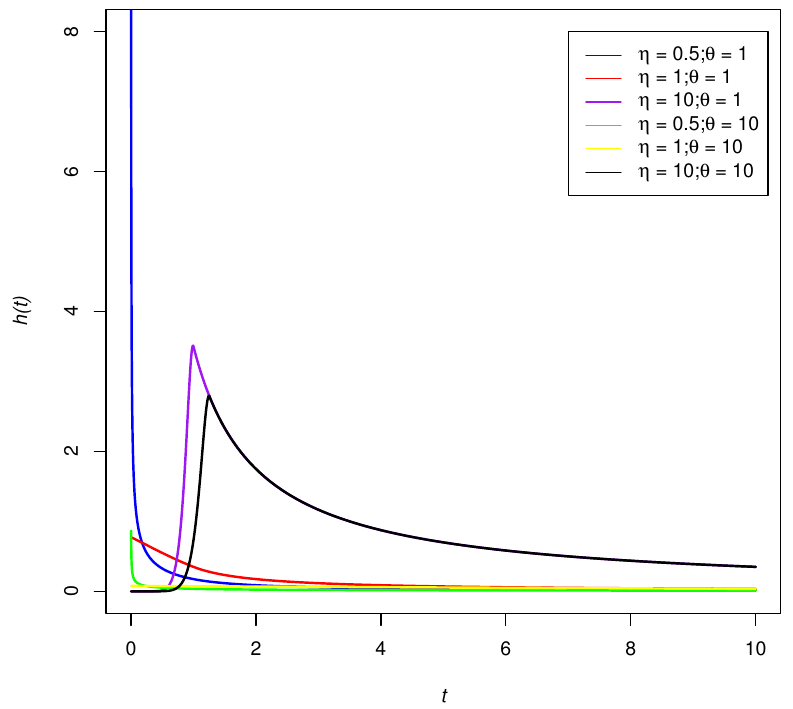
Figure 3. Hazard function of an EEP distribution with different